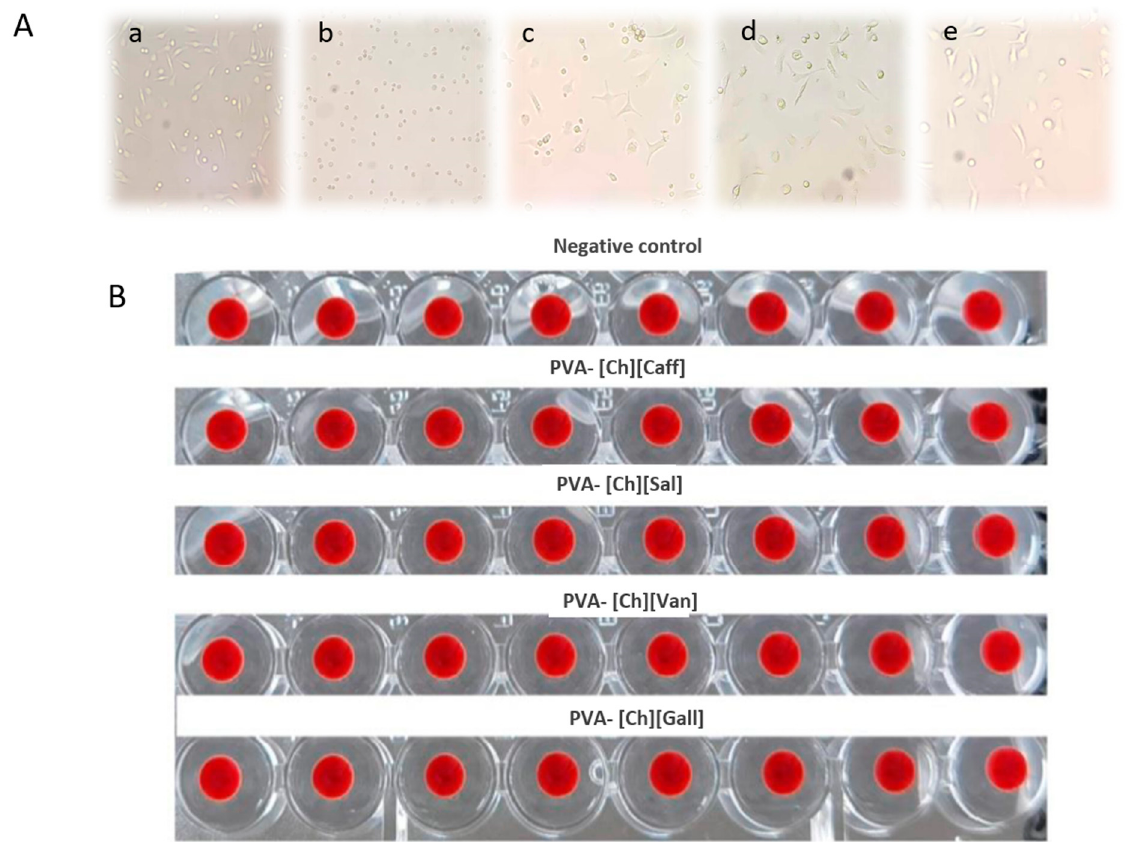
Figure 4. Qualitative results of cell culture and hemolysis test ( A ) Cell culture micrography after 24 h of incubation. ( a ) Control, ( b ) [Ch][Caff], ( c ) [Ch][Van], ( d ) [Ch][Sal], ( e ) [Ch][Ga]. ( B ) Hemolysis and agglutination test using mice blood after 24 h.